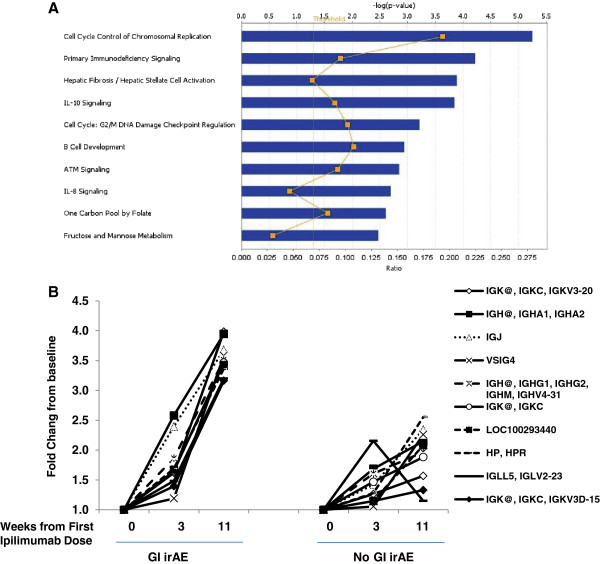
Expression of immune-related genes during ipilimumab treatment. (A) Functional interpretation of genes differentially expressed between baseline and week 11, as computed by Ingenuity Pathway Analysis (IPA) software (Ingenuity Systems). The P value reflects the significance of the enrichment of input genes in the functional category or pathway of interest. For every canonical pathway, IPA also provides the ratio of the number of genes from the input list that are annotated to the pathway to the total number of genes annotated to the pathway. (B) Fold change over time in expression of immunoglobulin-associated genes in the GI irAE and No-GI irAE groups. Genes shown were selected from the top 50 genes having the most prominent mean differences in on-treatment expression between the two GI irAE groups.